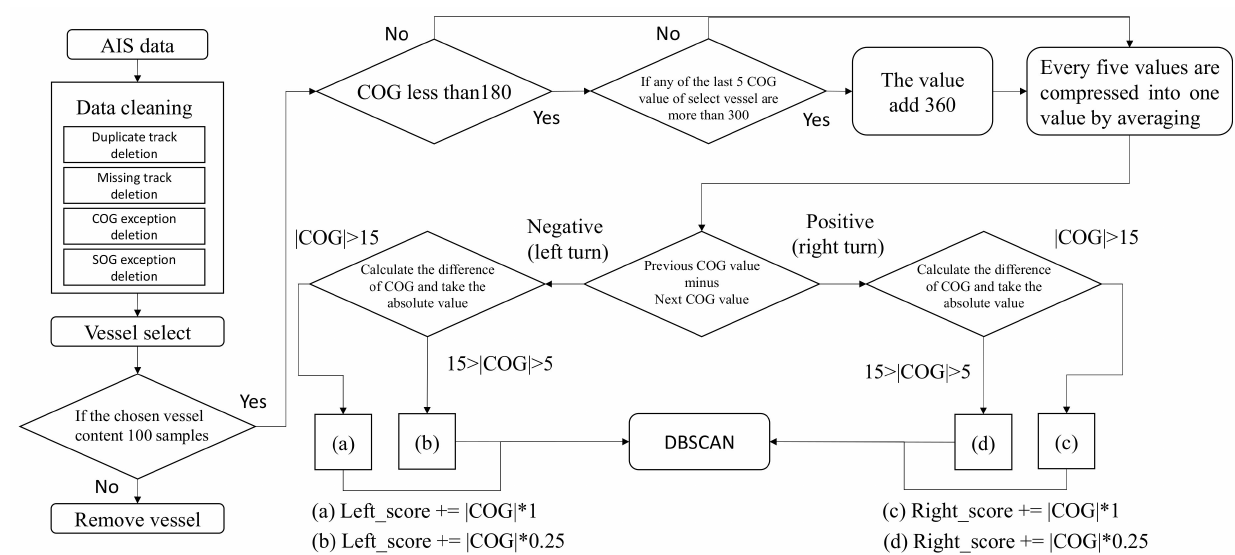
Figure 6. Transform 1D vessel trajectory data into 2D